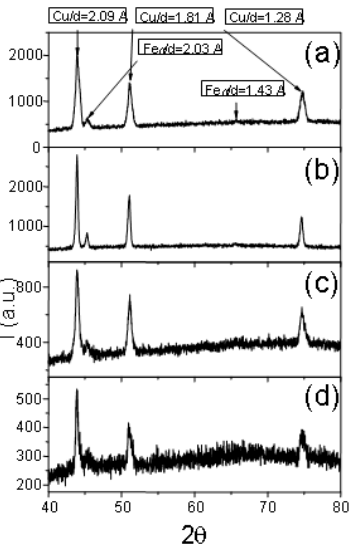
Figure 27. XRD patterns for Cu 63 Fe 37 microwires with different ρ values: 0.46 ( a ); 0.31 ( b ); 0.16 ( c ); 0.063 ( d ). Reproduced from Ref. [92], Figure 1.